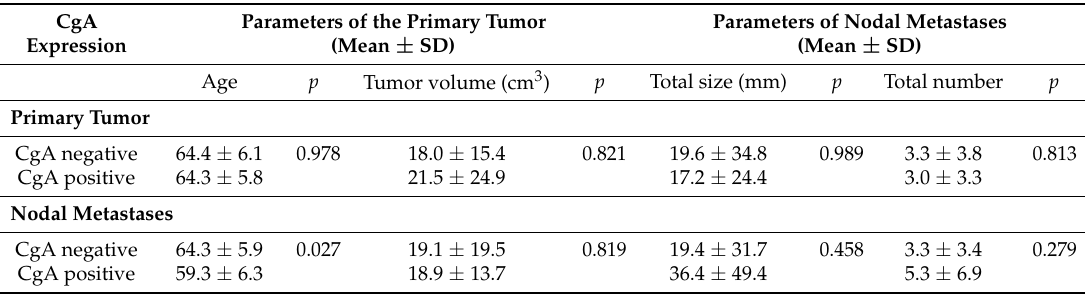
Table 2. Tumor features according to Chromogranin A expression.